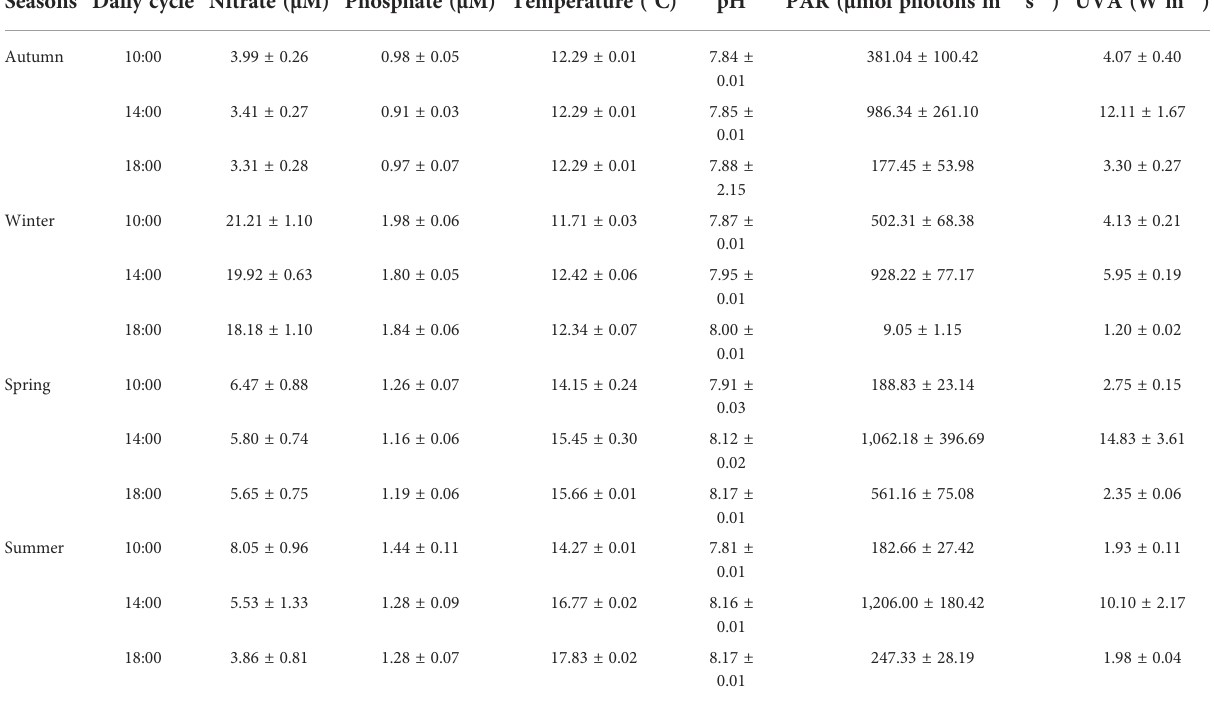
TABLE 1 The abiotic parameters nitrate (NO 3 − expressed in µM), phosphate (PO 43 − expressed in µM), temperature (expressed in °C), pH (expressed in a range from 0 to 14), photosynthetically active radiation (PAR expressed in µmol photons m − 2 s − 1 ), and ultraviolet-A radiation (UVA expressed in W m − 2 ) at Cochoa Beach in Valpara ı ́ so Bay during daily cycle experiments with Lessonia spicata in autumn, winter, spring, and summer, between 2019 and 2020. Seasons Daily cycle Nitrate (µM) Phosphate (µM) Temperature